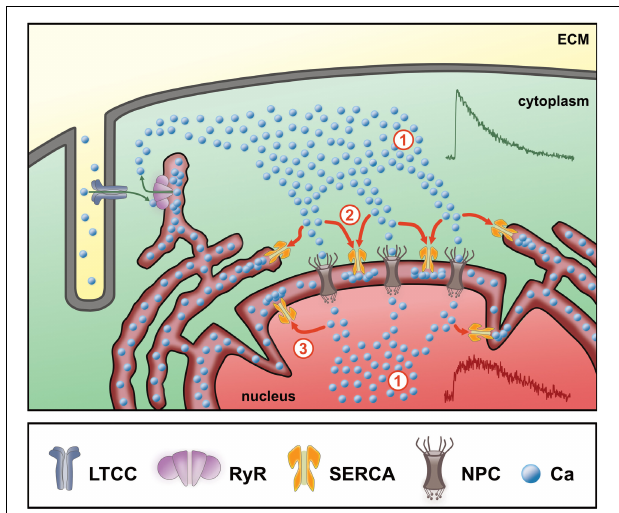
FIGURE 9 | Scheme of nuclear Ca regulation in ventricular cardiomyocytes. During Ca-induced Ca release (green arrows) Ca from the extracellular matrix (ECM) enters the cytoplasm via L-type Ca channels (LTCC) into the junctional cleft between t-tubular membrane and sarcoplasmic reticulum (SR). Upon binding to ryanodine receptors (RyR) the SR releases stored Ca to cause the systolic Ca transient (CaT) in the cytoplasm (#1). The Ca gradient between the cytosol and the nucleus then drives the Ca ions through the nuclear pore complexes (NPC, #1). At this point, the magnitude of the cytoplasmic CaT (green CaT) represents the major determinant for the nucleoplasmic Ca increase (red). The Ca increase in the nucleus is further dependent on the activity of SERCA pumps (#2) located in the SR and nuclear envelope (perinuclear stores), which actively reduce the amount of free Ca reaching the nucleoplasm, hence limit the nucleoplasmic Ca increase. SERCA pumps located in the inner nuclear membrane (#3) may additionally contribute to modulate the systolic nuclear Ca